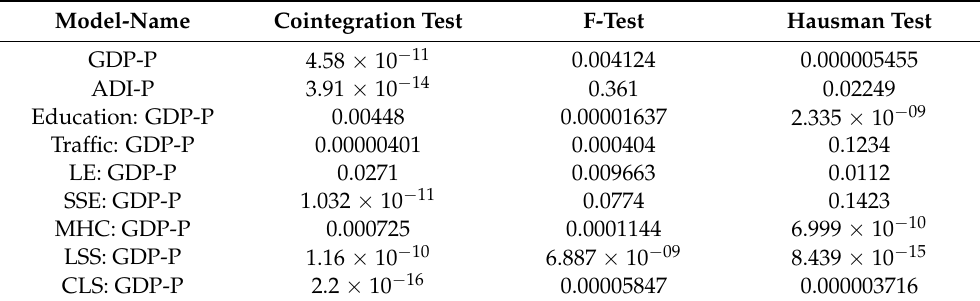
Table 8. Test results of positive emotions and model